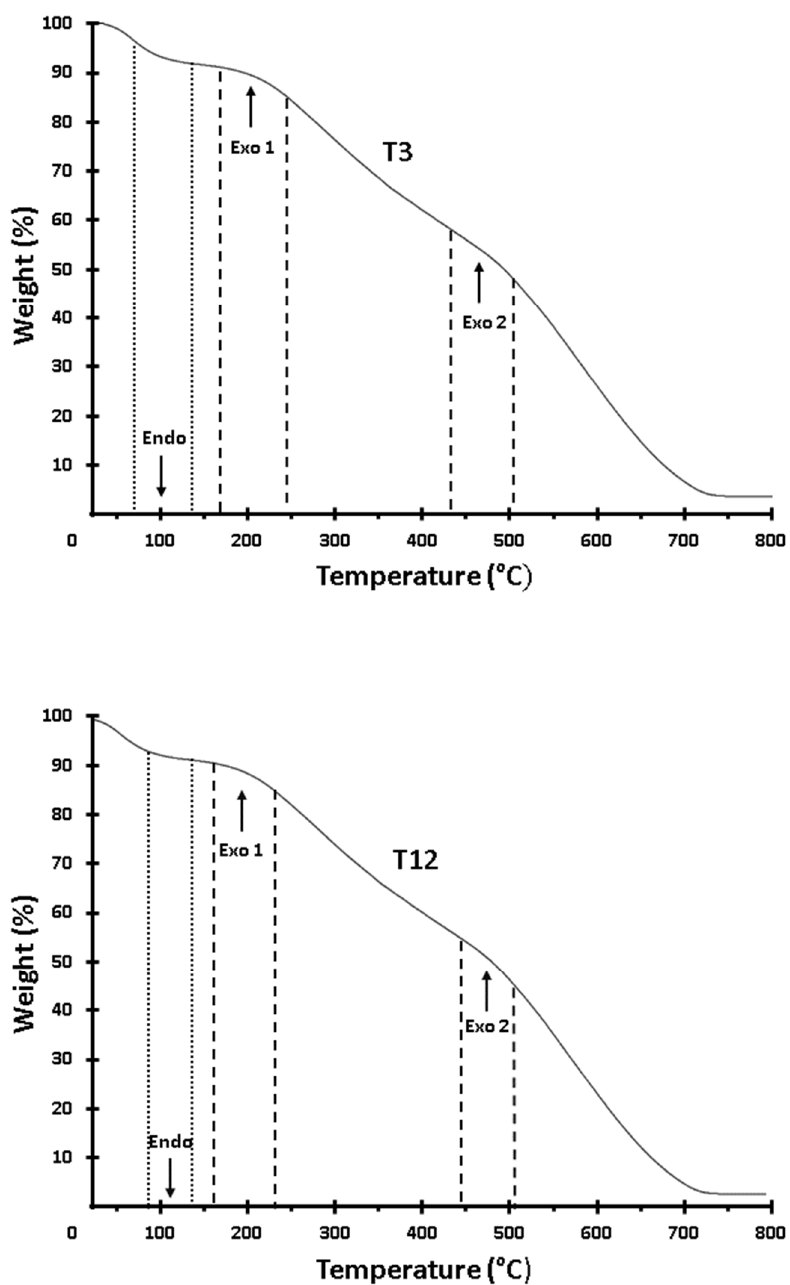
Figure 1. Thermograms indicating sample weight loss regions in thermogravimetric analysis (TGA) of humic acids from organic amended soils. Tn—treatment number: T3—biochar (BIO, with field age of 0.5 years) and T12—farmyard manure (FYM, 116 years).